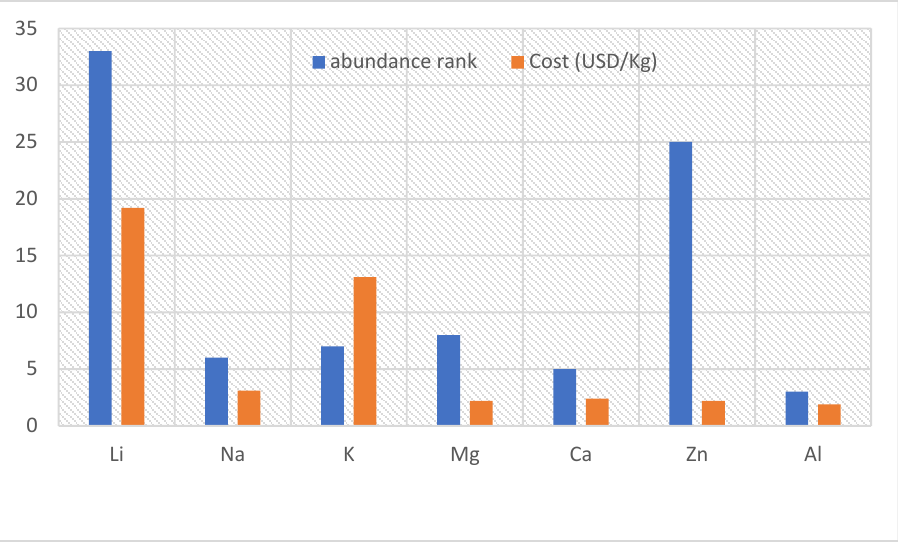
Figure 4. Different charge carriers ’ relative abundance rank and cost (Li + , Na + , Mg 2+ , Ca 2+ , Zn 2+ , and Al 3+ ) for rechargeable batteries.